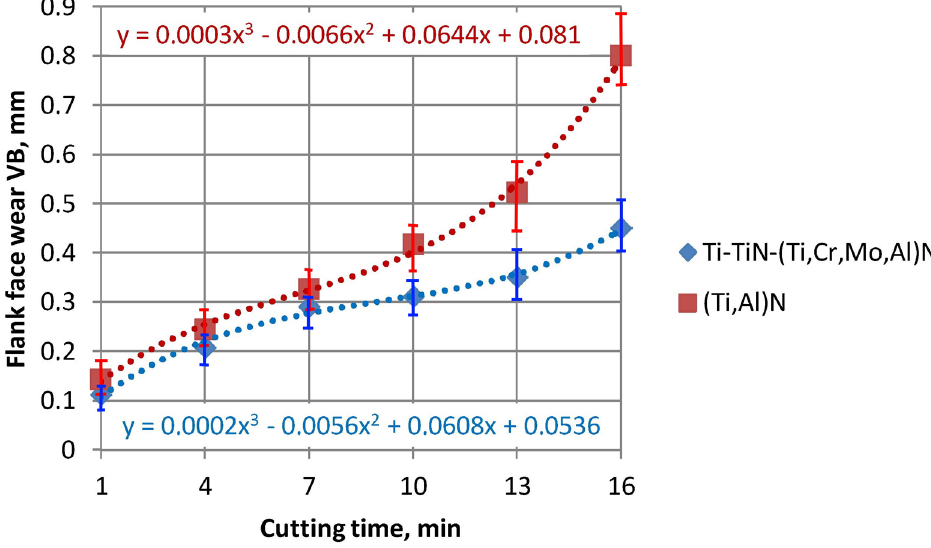
Figure 6. Relation between cutting time and flank wear (VB) on coated carbide tools during the turning of AISI 1045 steel: v c = 300 m/min, f = 0.25 mm/rev, a p = 1.0 mm.